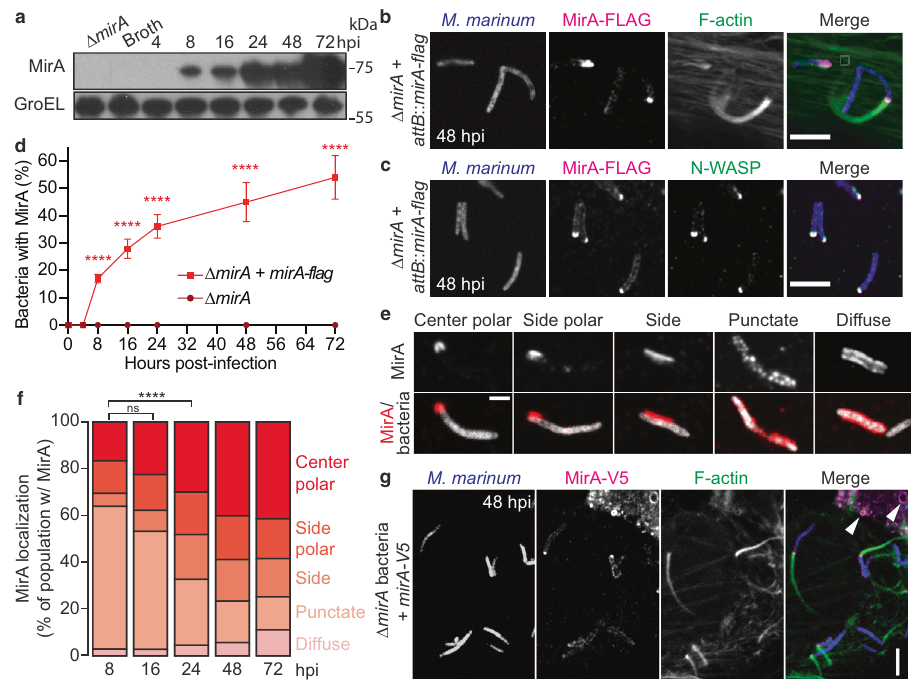
Fig. 3 MirA is secreted in response to infection and colocalizes with N-WASP and F-actin. a Immunoblot of MirA levels on the bacterial surface (Genapol X-080 supernatant) in broth or during infection of RAW 264.7 cells. GroEL2 is shown as the loading control. Endogenously expressed MirA- FLAG (magenta; anti-Flag) with b F-actin (green; Alexa 488 phalloidin) or c N-WASP (green; anti-N-WASP) colocalization at the M. marinum (blue; EBFP2) surface during infection of U2OS cells at 48 hpi. Scale bar is 5 µ m. d Quanti fi cation of indicated M. marinum strains with MirA surface localization during infection of U2OS cells. e Representative micrographs depicting the fi ve categories of MirA-FLAG localization on the bacterial surface during infection of U2OS cells at 48 hpi. Scale bar is 1 µ m. f Time course of MirA-FLAG localization on the bacterial surface during infection of U2OS cells. g Ectopically expressed MirA-V5 (magenta; anti-V5) localization with Δ mirA bacteria (blue; tdTomato) and F-actin (green; Phalloidin-iFluor 405) in U2OS cells 52 hpt and 48 hpi. Scale bar is 3 µ m and white arrows indicate transfected MirA localizing to eukaryotic lipid droplet organelles. Data in d are the mean ± SD; n = 3 independent replicates and an unpaired two-tailed t test was used to assess signi fi cance. The data in f is the aggregate of 3 independent experiments and a chi-square test is used; ns = non-signi fi cant and **** p < 0.0001. Data shown in a , g are representative of three independent experiments. Source data are provided as a Source data fi